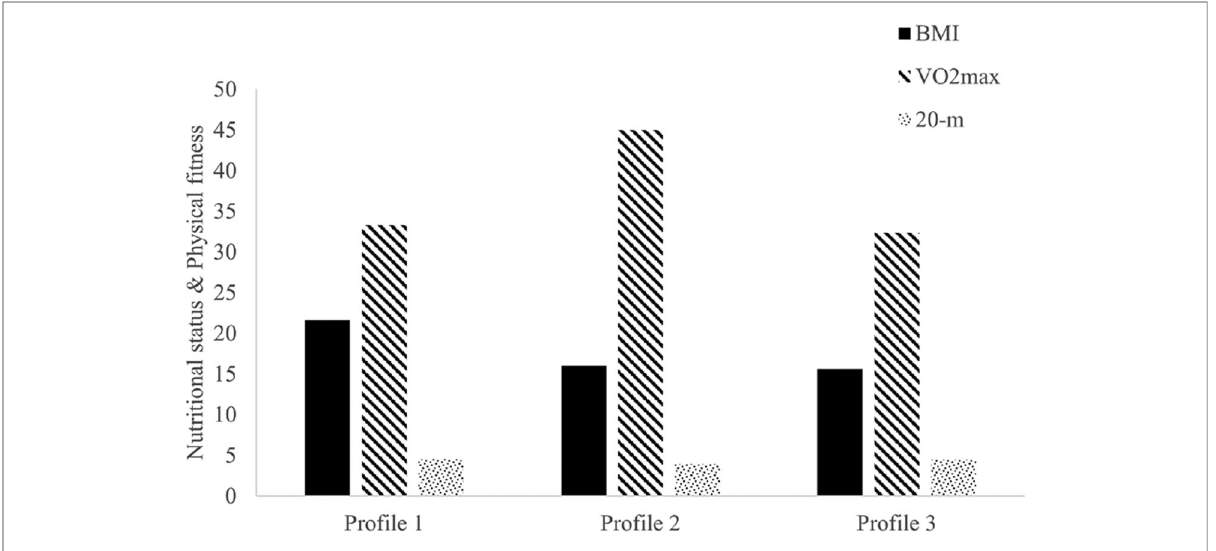
FIGURE 1 Characteristic of classi fi ed three pro fi les. Note: BMI, Body mass index, values are within the Normal weight range for three pro fi les. Pro fi le 1 — high BMI, poor VO